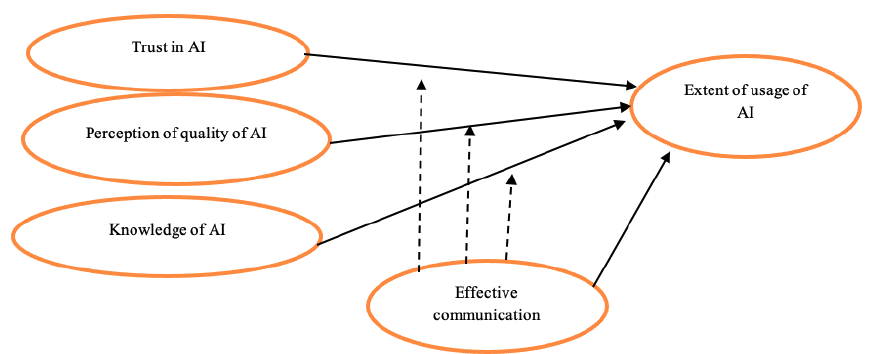
Figure 1: Conceptual